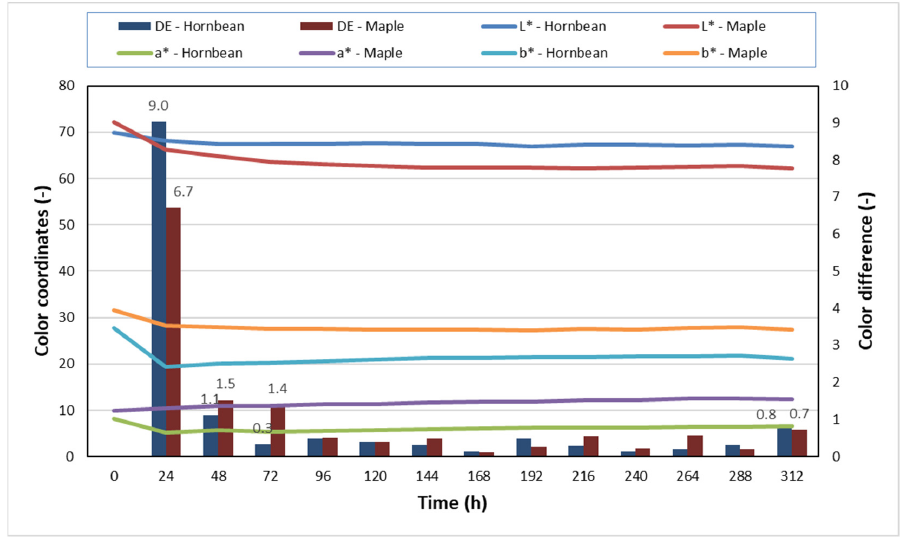
Appl. Sci. 2021 , 11 , x FOR PEER REVIEW Figure 3. Change of color space coordinates and size of color difference during hot-air drying (60 °C).